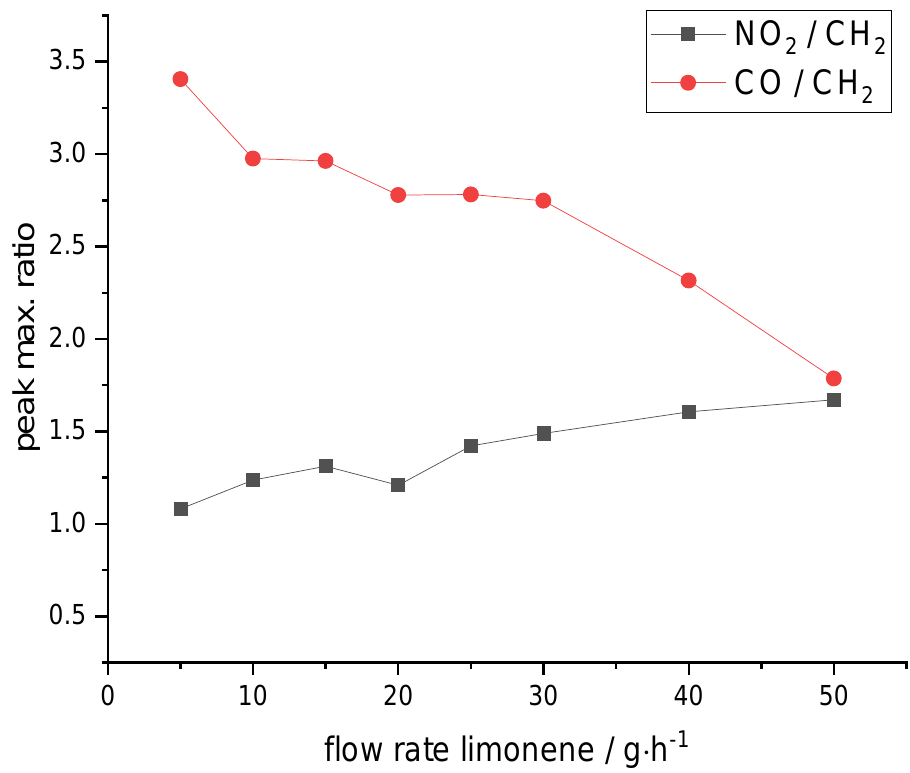
Figure 9. Peak maximum ratios of FTIR absorption of CH, C=O and NO 2 stretching mode at an HMDSO flow rate of 10 g∙h −1 and different lim flow rates.